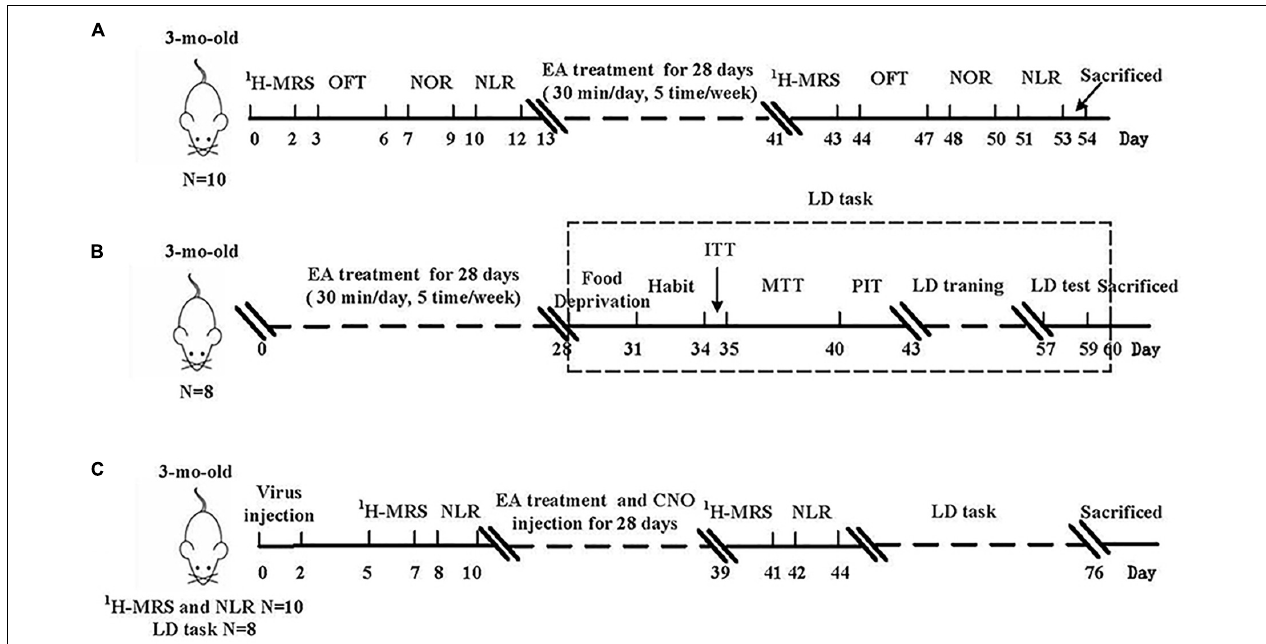
FIGURE 1 | Experimental design of this study. (A,B) The experimental procedure of test with EA treatment. (C) The experimental procedure shows a strategy for EA treatment and hM4Di DREADDs inhibited. EA, electro-acupuncture; 1 H-MRS, PRESS- 1 H Magnetic resonance spectroscopy; OFT, open field test; NOR, novel